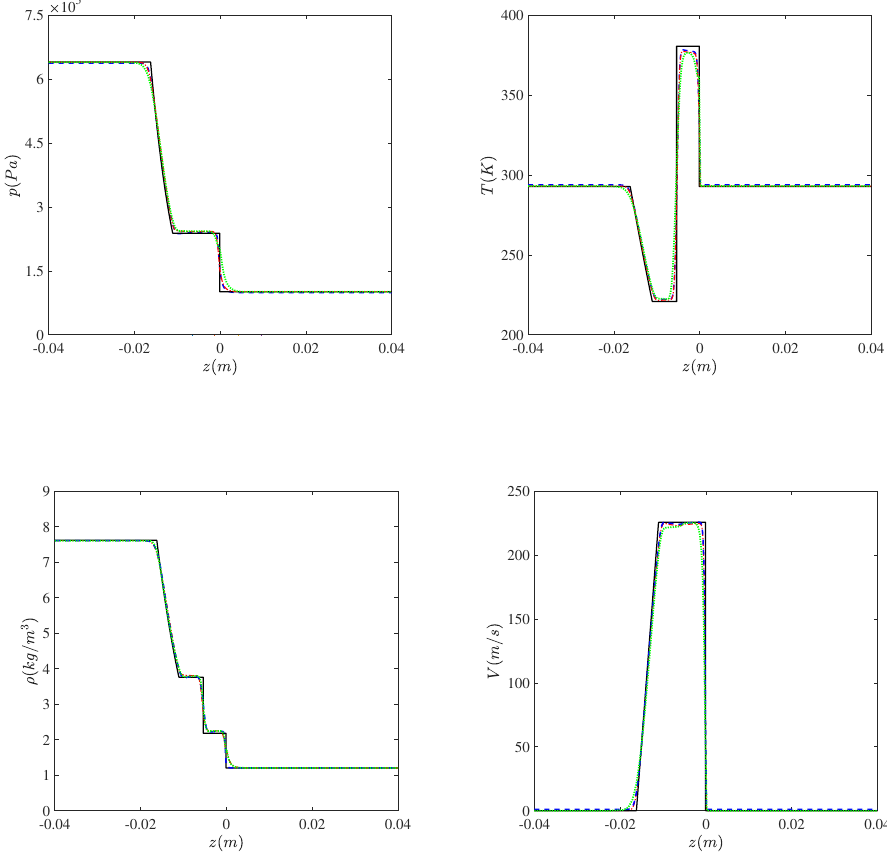
Figure 2. Profiles of pressure ( top left ), temperature ( top right ), density ( bottom left ), and velocity ( bottom right ) along the shock tube at the impact time instant, compared to the exact inviscid solution (black solid line), for three different solutions that are CFD I (dotted green line), CFD II (red dash-dotted line) and CFD III (dashed blue